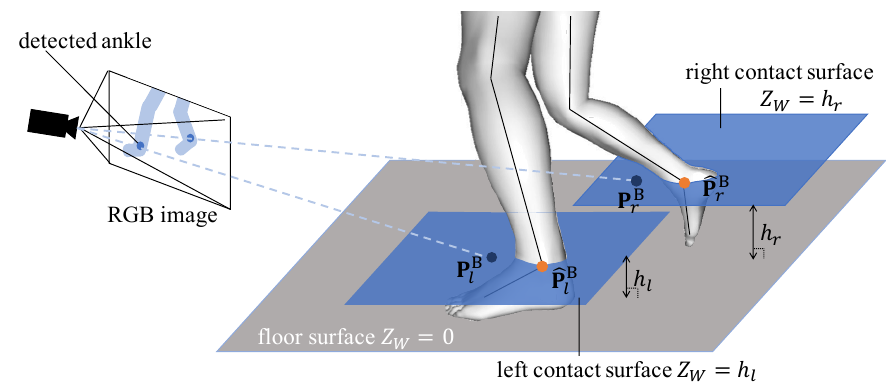
Figure 2. Visualization of the ground contact